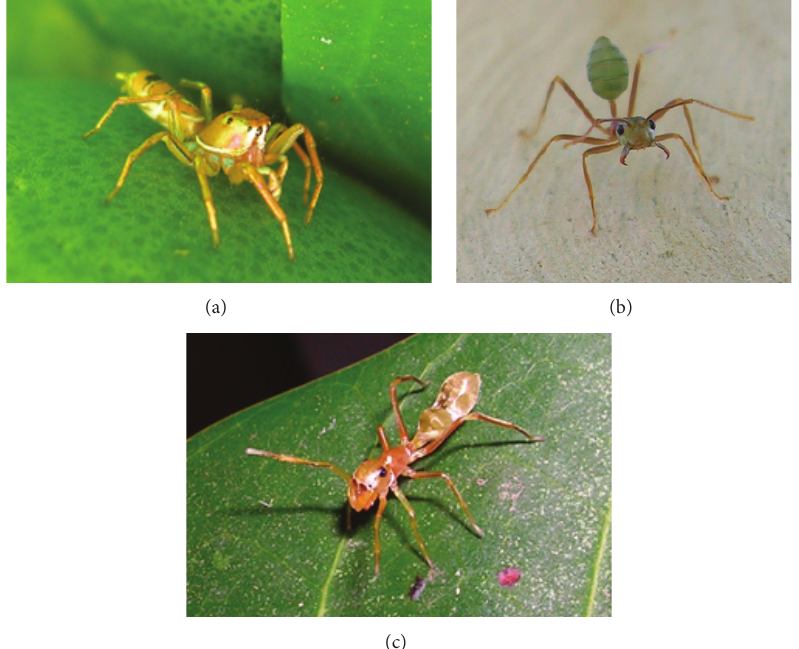
Figure 1: Ant-associating salticids (a) Cosmophasis bitaeniata , chemical, aggressive myrmecophile and (c) Myrmarachne smaragdina , myrmecomorphic Batesian mimic, and their common model ant species (b) Oecophylla smaragdina in an aggressive display